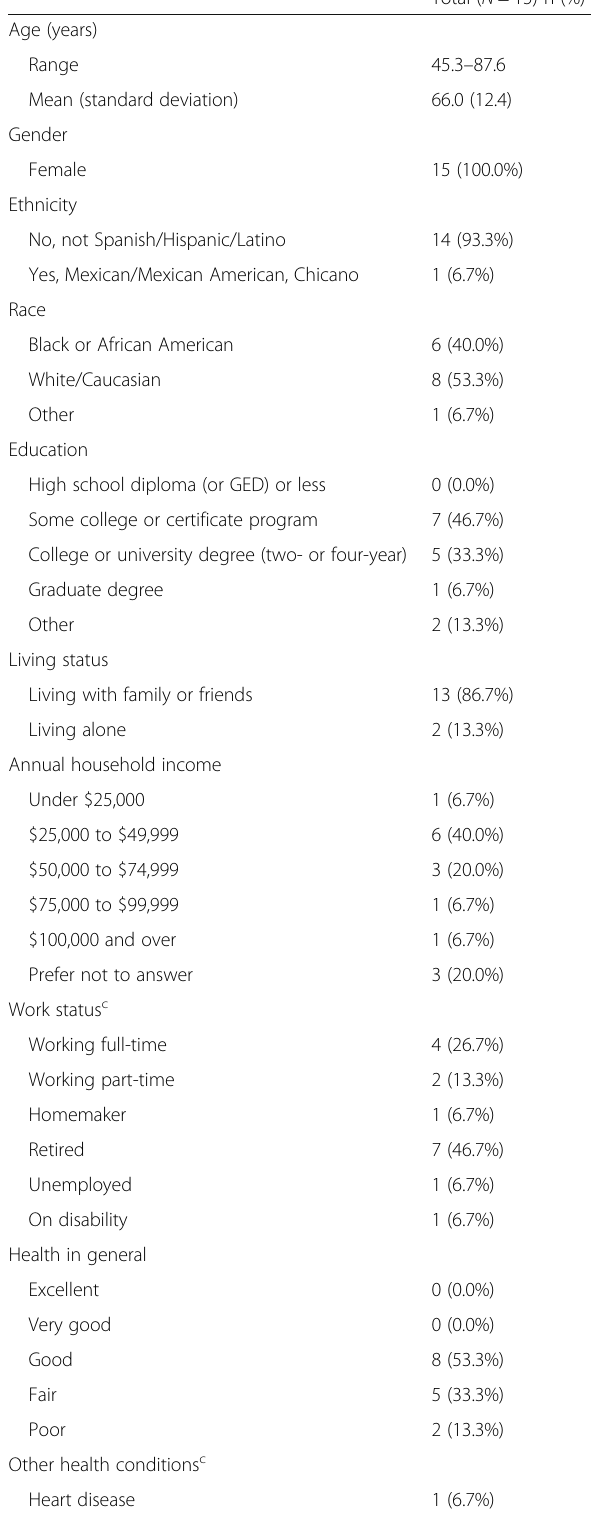
Table 1 Patient interviews: Demographic and health information (self-reported) a